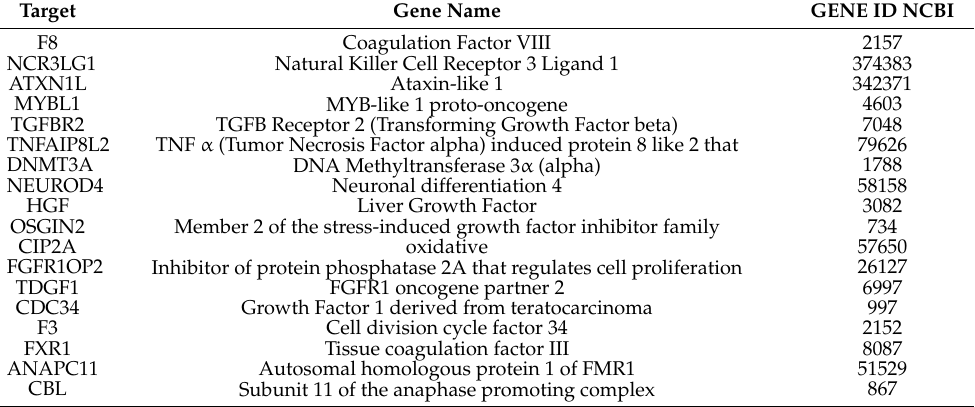
Table 6. Targets of miR-1244-1.